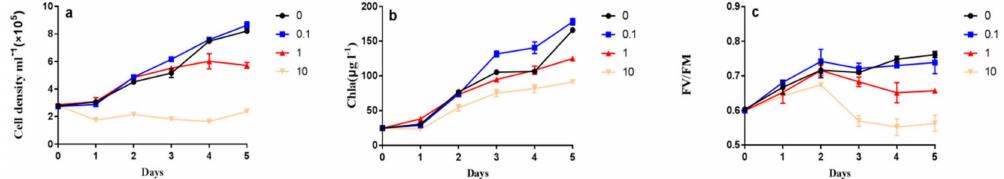
Figure 1. C. pyrenoidosa in response to bisphenol A (BPA). ( a ) cell density, ( b ) the content of Chla, ( c ) photosynthesis